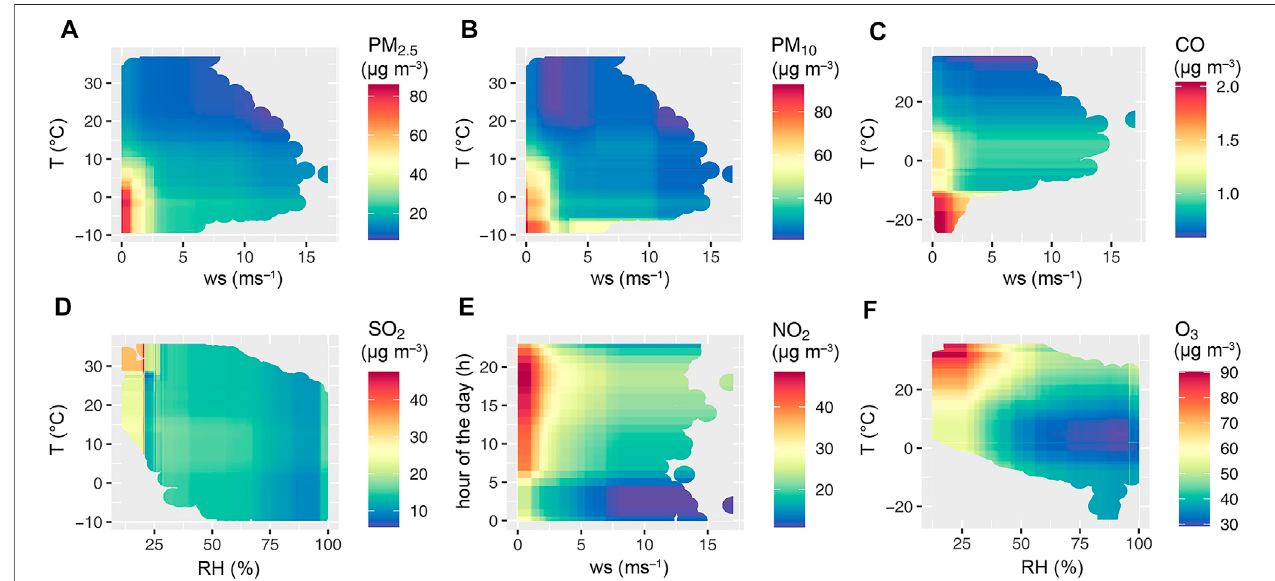
FIGURE2 | Two-way interactions between the mostin fl uential covariates: (A) PM2.5 -air temperature (T) and wind speed (ws); (B) PM10 -air temperature (T)and wind speed (ws); (C) CO- air temperature (T) and wind speed (ws); (D) SO 2 - air temperature (T) and relative humidity (RH); (E) NO 2 -hour of the day (h) and wind speed (ws); and (F) O 3 - air temperature (T) and relative humidity (RH).